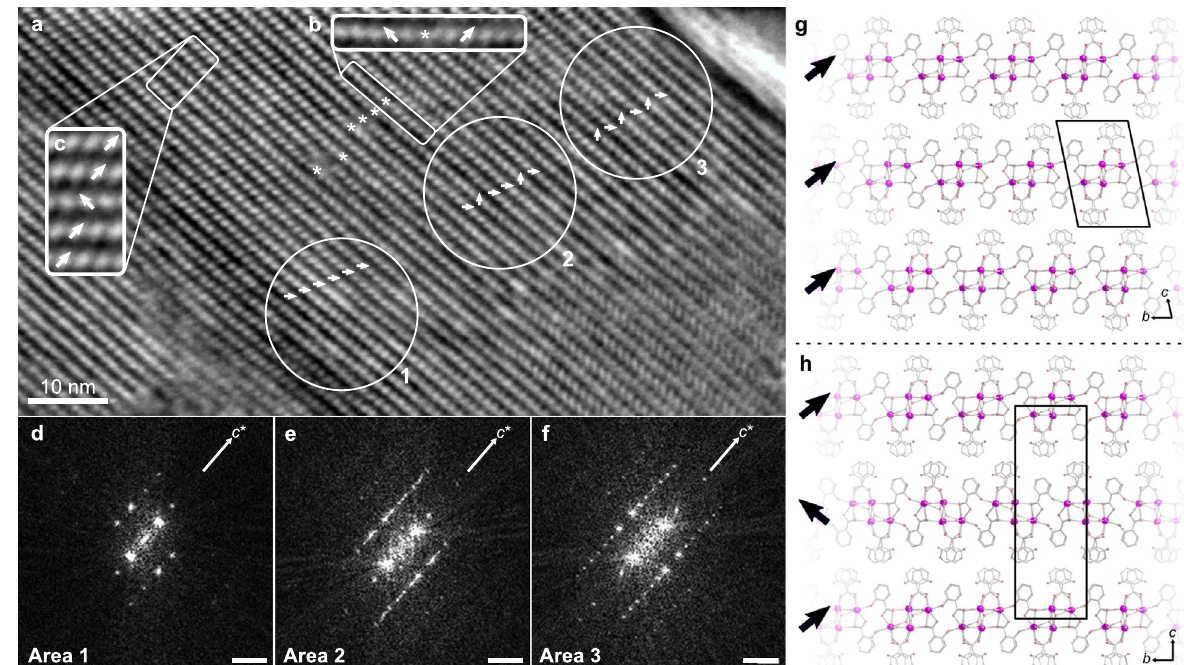
Fig. 4 iDPC-STEM image reveals disorder in BSS-PB. a – c Domains of disorder are found in BSS while imaged along the [100] direction, showing alternation of the layer orientation both within ( b ) and between the layers ( c ). Arrows indicate the orientation of the layers. Stars (*) indicate switching of the orientation within a single layer. d Domains with a 17 Å c -axis are found as evidenced by the fast Fourier transform (FFT), showing a single layer orientation. e Domains of disordered stacking are also observed as diffuse streaking perpendicular to the layer. f Domains showing a doubled 34 Å c